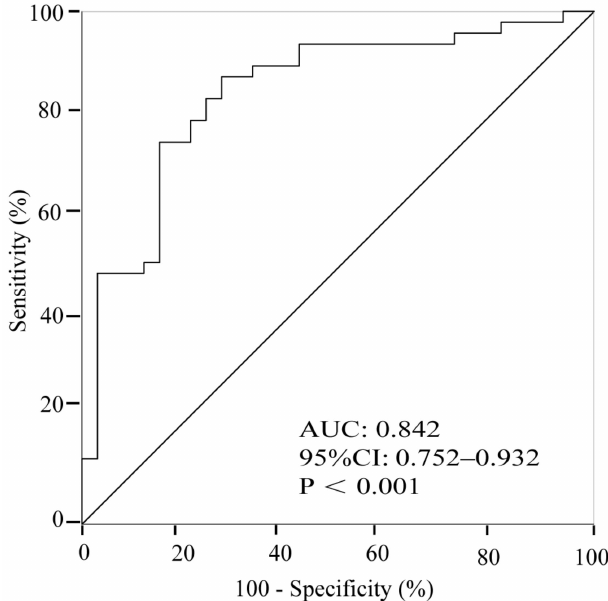
Figure 3. The ROC curve of 24-hour urinary sodium excretion to predict the response to oral rehydration saline treatment in pediatric cases of vasovagal